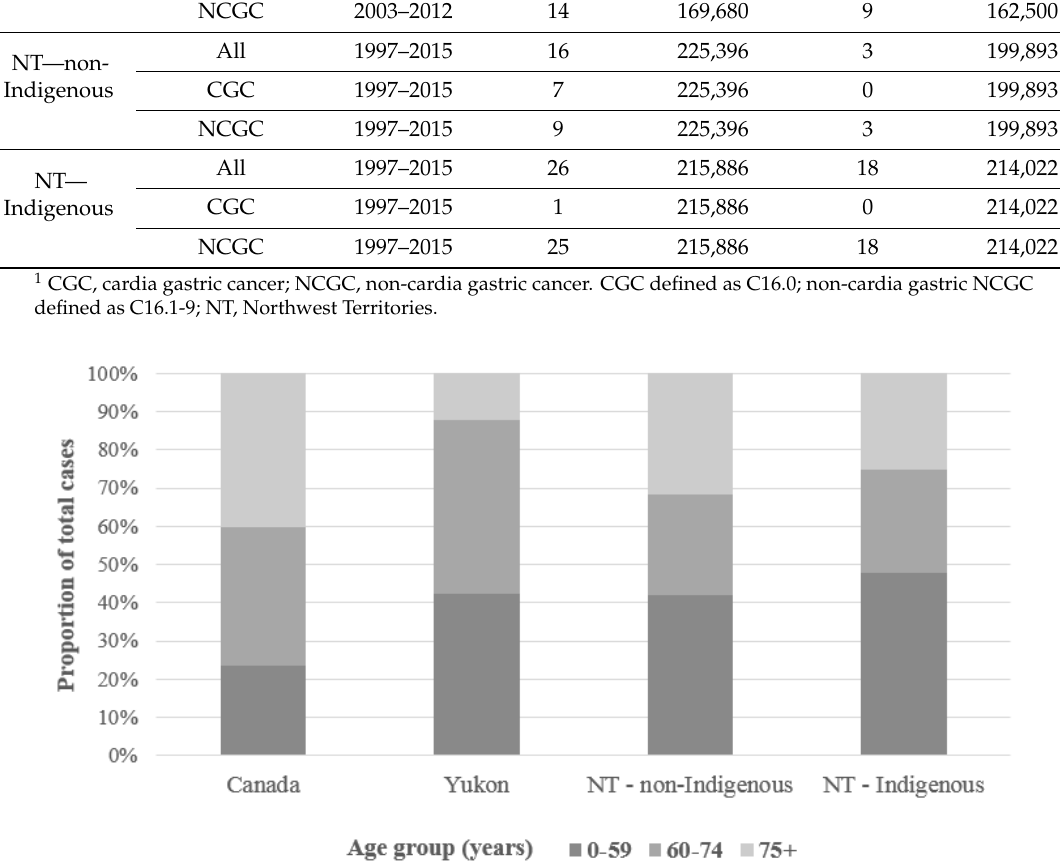
Table 1. Number of gastric cancer cases and person-years by gastric cancer subsite, population and sex; northern territories, Canada; various years.